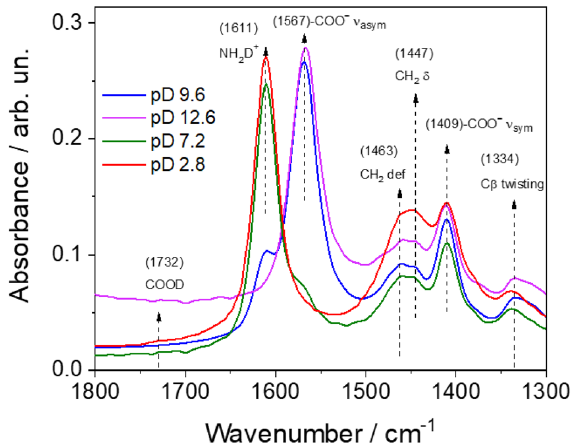
Figure 6. FTIR absorption spectra at 25 °C of D 2 O solutions of l-lysine at different pDs (2.8, red line; 7.2, green line; 9.6, blue line; 12.6, magenta line). The spectra have been acquired in ATR mode.